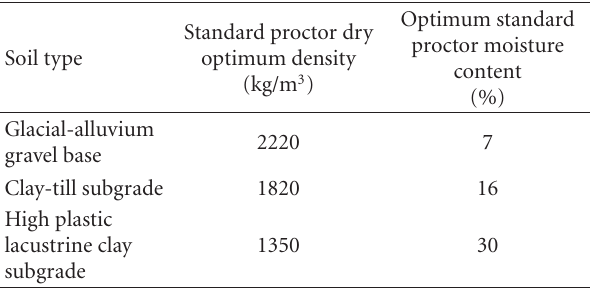
Table 2: Standard proctor optimum dry density and moisture content data of soils considered in